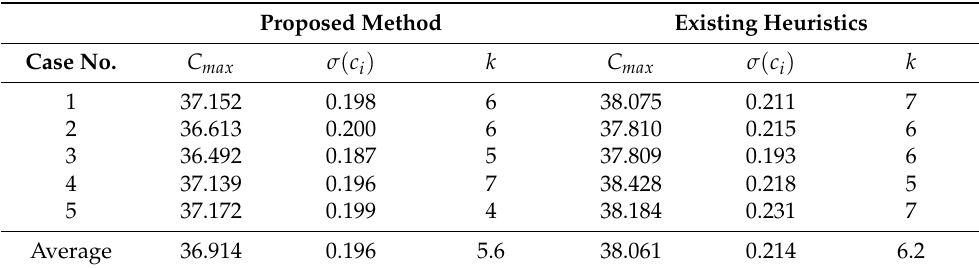
Table 4. Result of the experiment for resilience in type phase (unit: